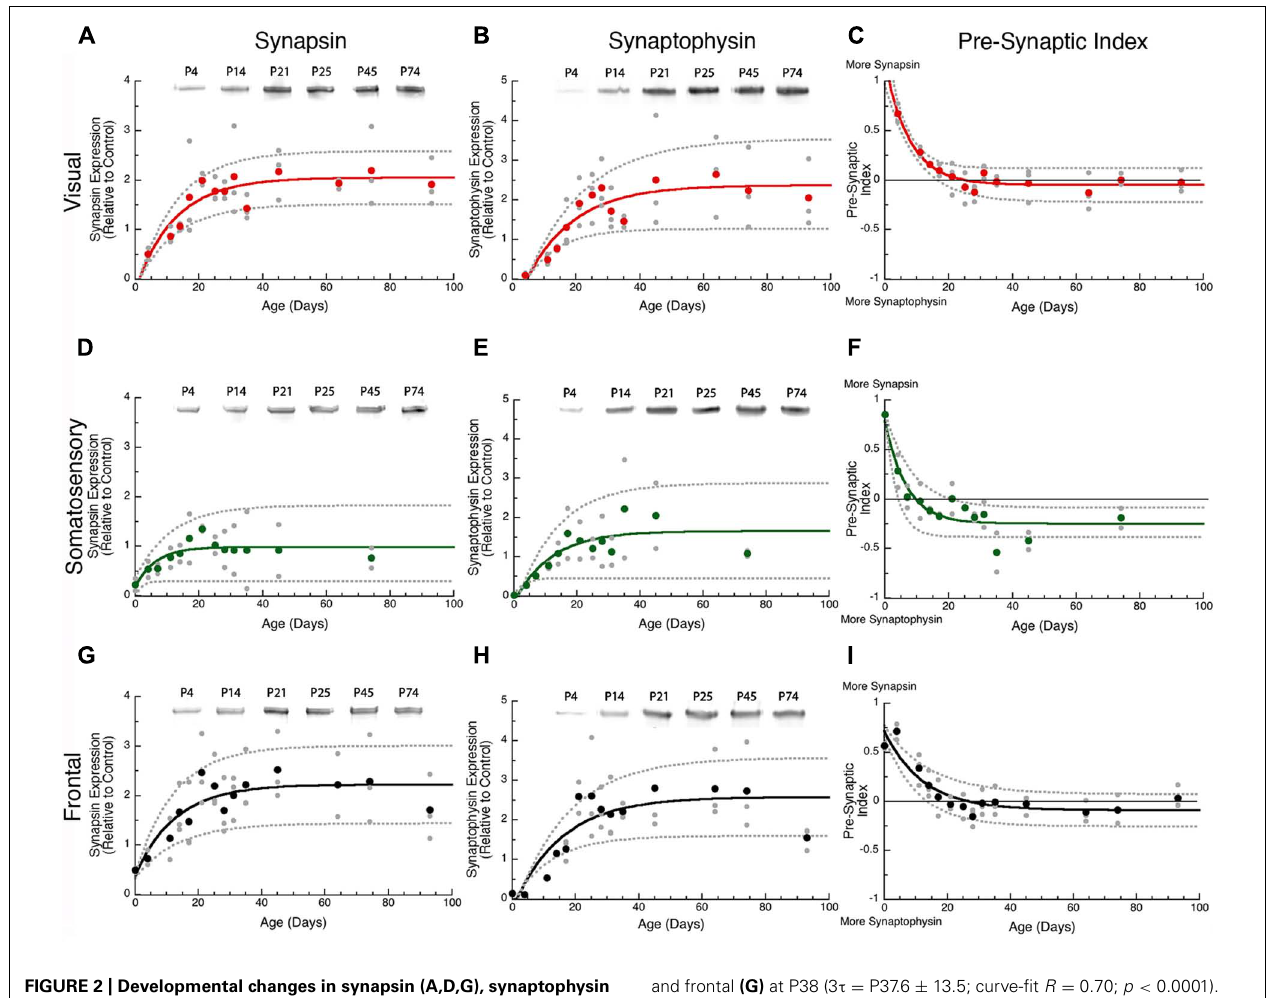
and frontal (G) at P38 (3 τ = P37.6 ± 13.5; curve-fit R = 0.70; p < 0.0001). Synaptophysin reached adult levels in visual (B) at P45 (3 τ = P44.8 ±